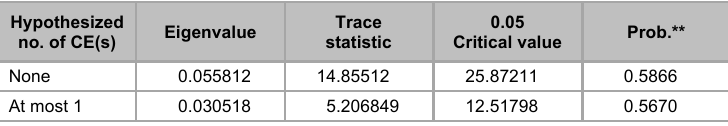
Johansen cointegration test (trace)